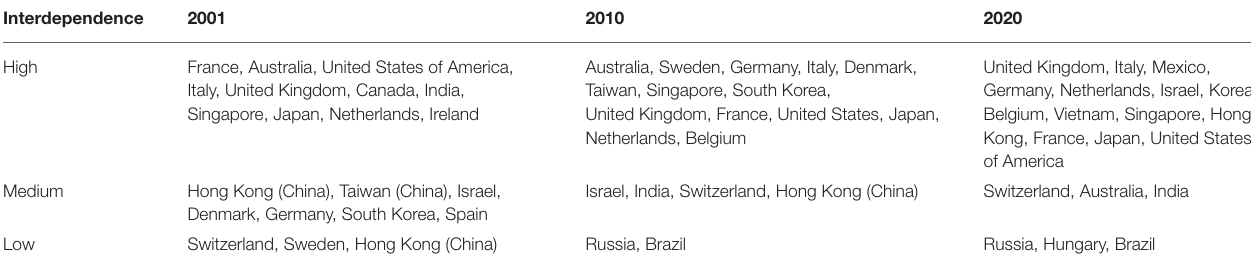
TABLE 8 | Ranking of China’s top 20 trading partners for medical devices by interdependence in 2001, 2010, and 2020. Interdependence